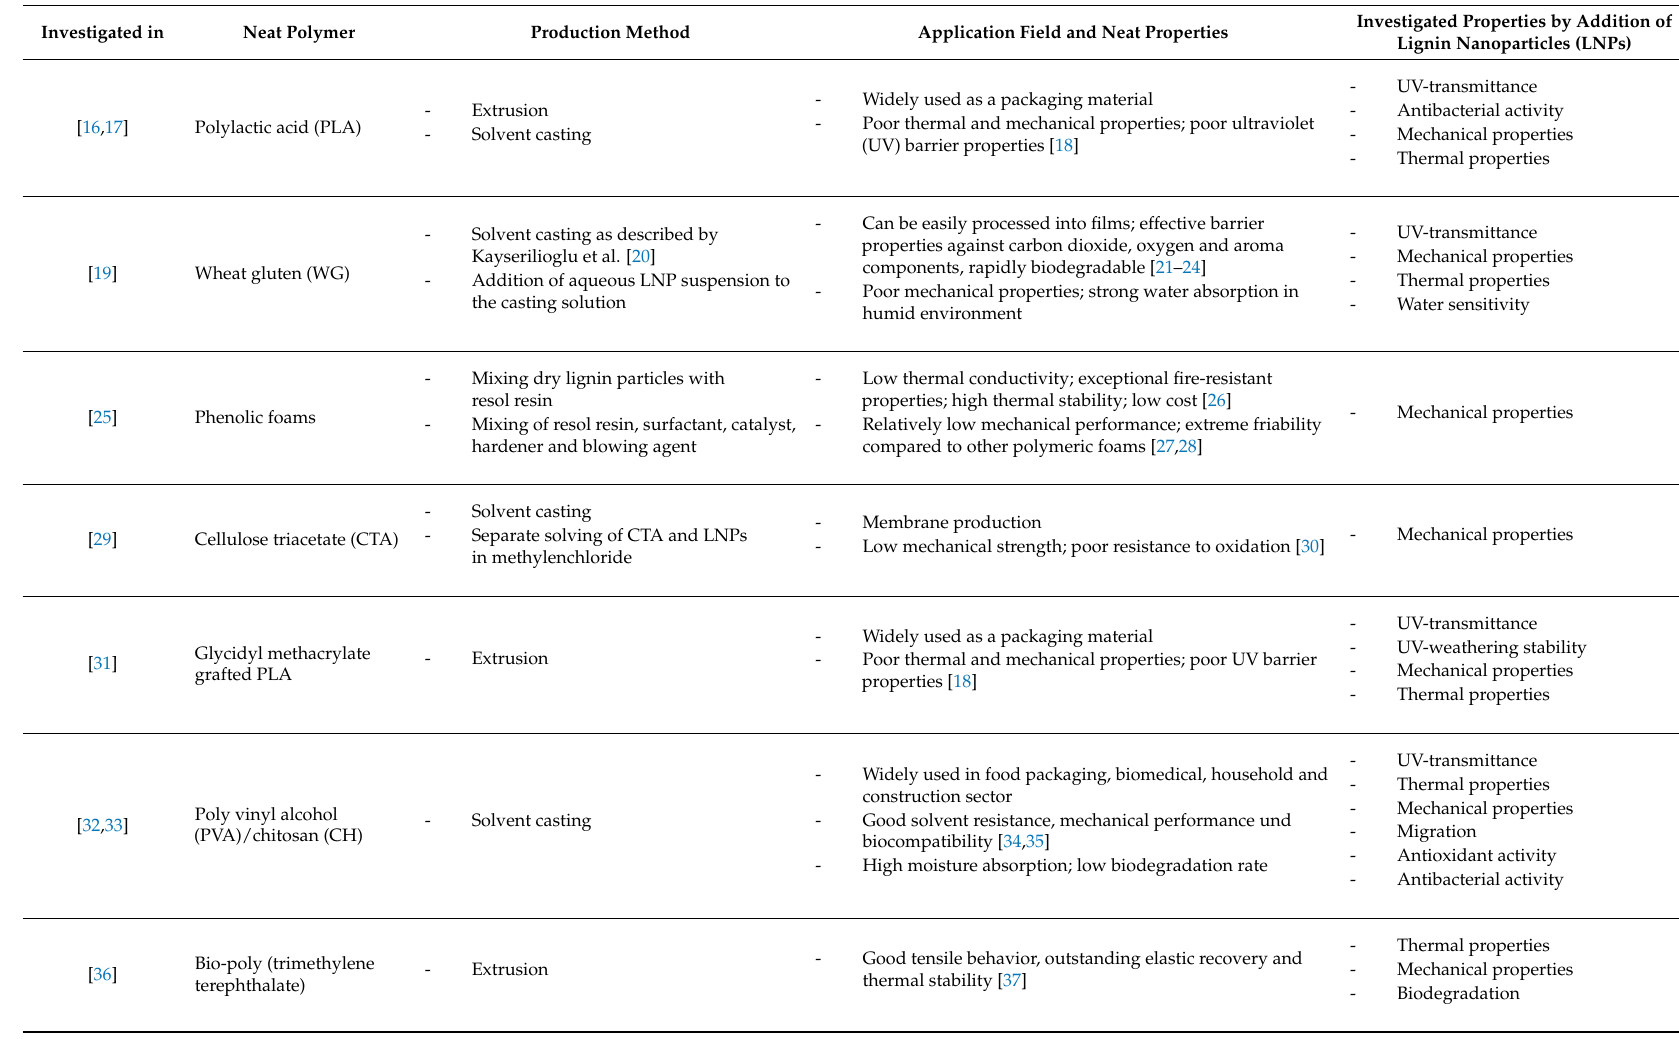
Table 1. Overview of investigated polymer